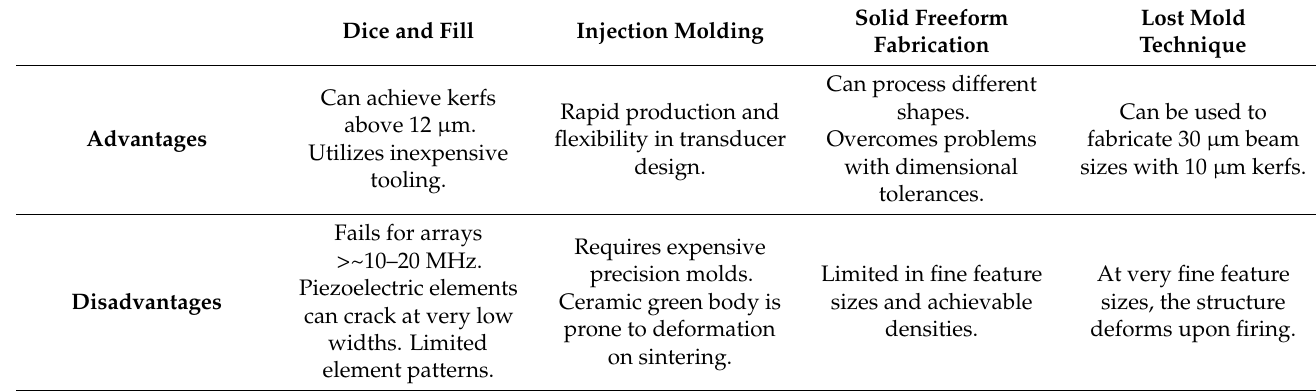
Table 1. Advantages and disadvantages of common composite transducer processing